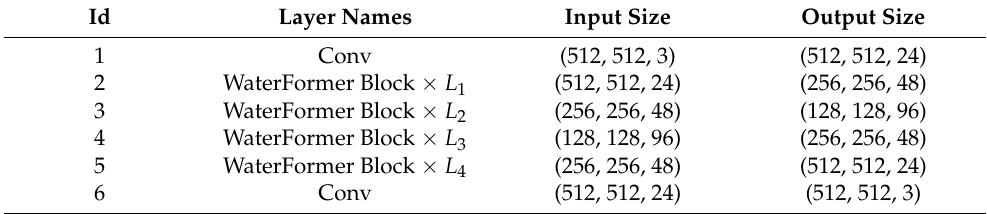
Table 1. Data flow of